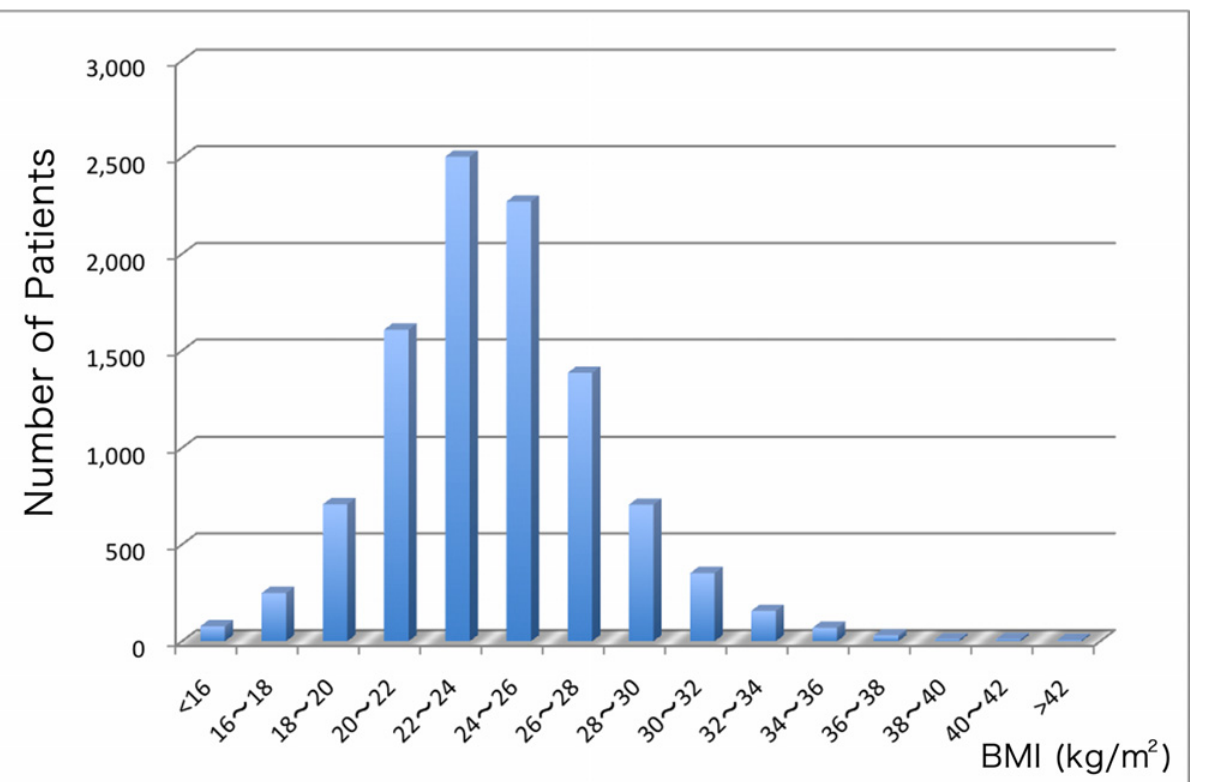
Fig 1. Distribution of BMI values. The distribution of BMI for 10,142 patients is